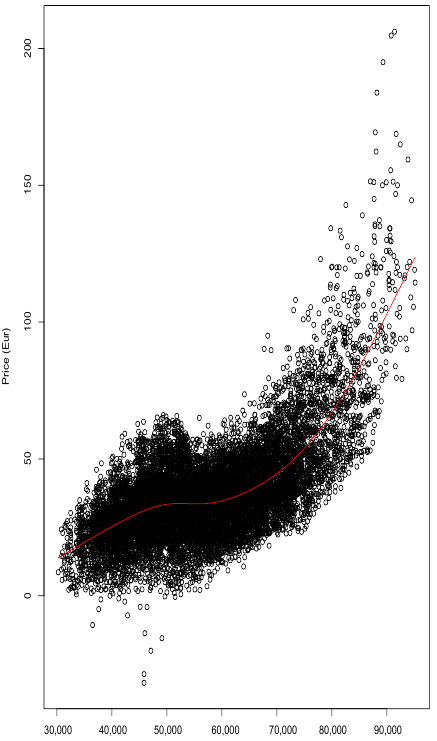
Figure 2. Empirical PLC of the French power